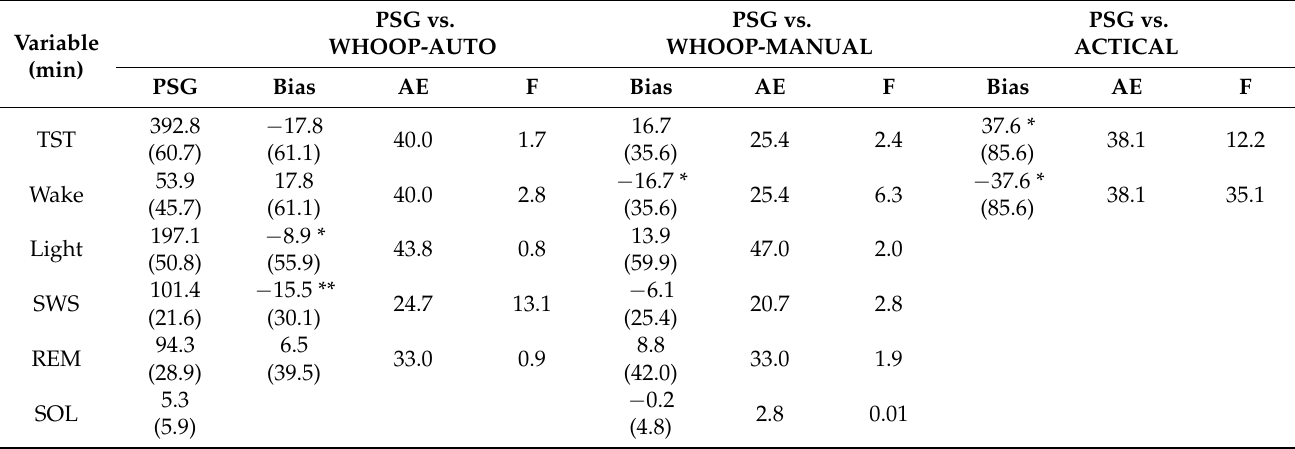
Table 1. Comparison of sleep variables determined by PSG, WHOOP-AUTO, WHOOP-MANUAL and ACTICAL. PSG Variable (min)